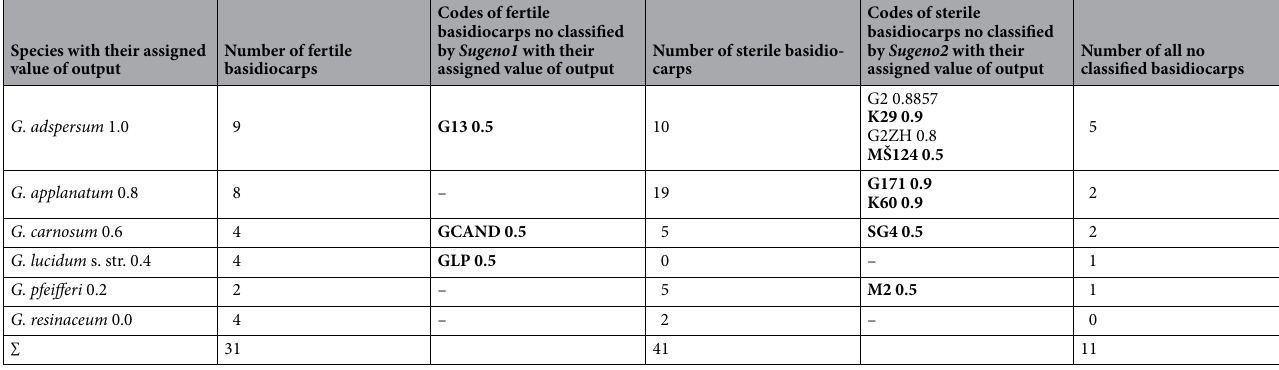
Table 7. No classified Ganoderma basidiocarps processed by FIS Sugeno1 and Sugeno2 among all basidiocarps